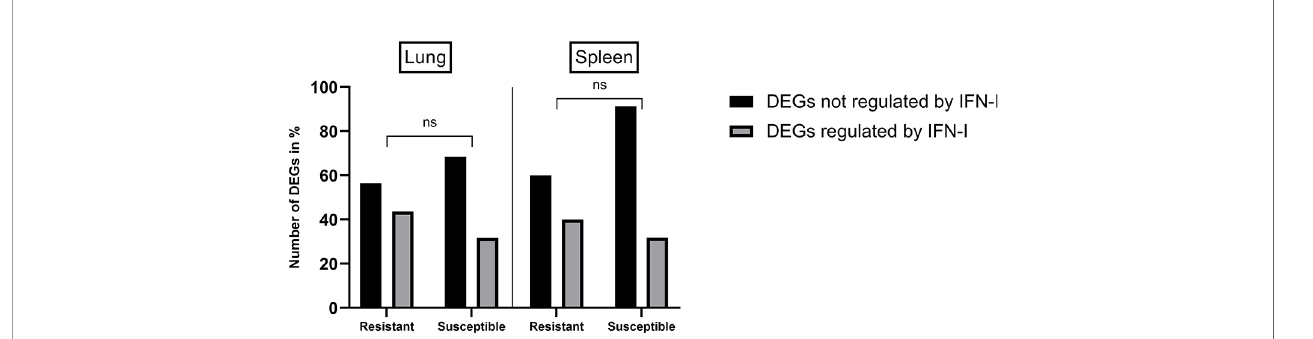
FIGURE 5 | Percentages of DEGs identi fi ed in lungs and spleens from resistant and susceptible H5N8 inoculated chickens that are regulated or not by IFN-I based on results obtained from the database Interferome (v2.1). Non-signi fi cant differences in the percentages of DEGs were seen between resistant and susceptible birds (ns) P ≥ 0.05; 2-way